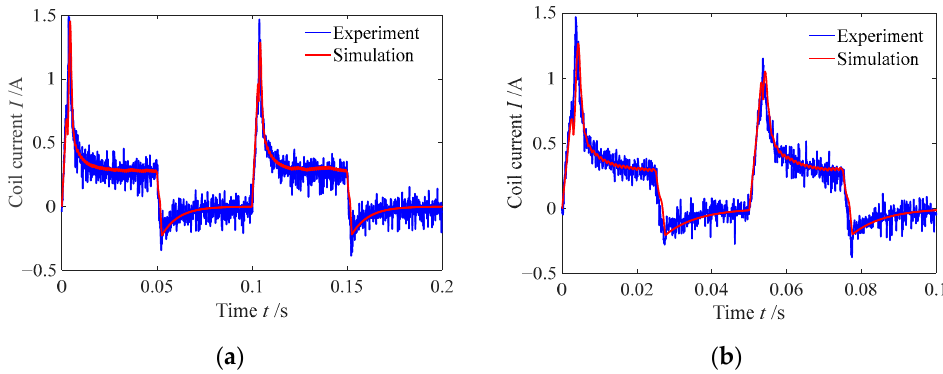
Figure 5. Comparisons of the coil current under different frequencies: ( a ) 10 Hz; ( b ) 20 Hz.